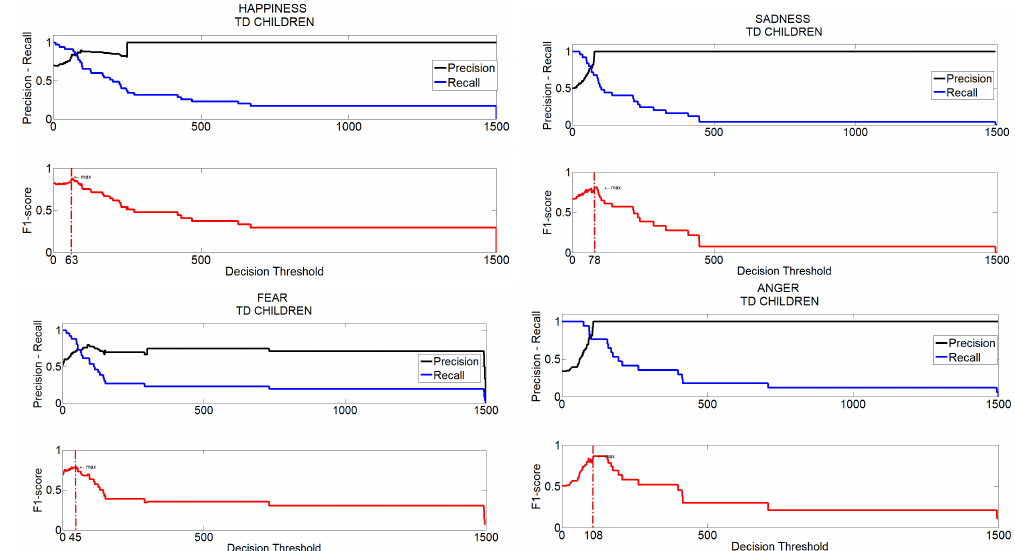
Figure 7. Expressions by TD children: classification accordance between system and experts while varying decision threshold.